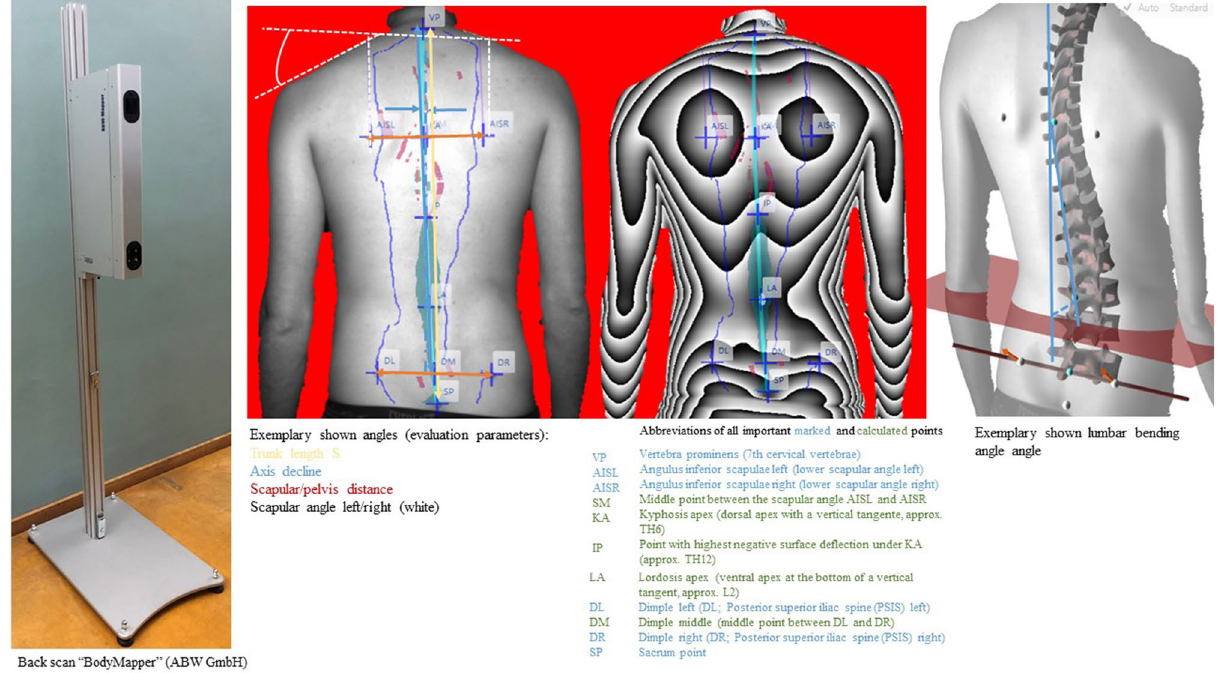
Figure 1. Display of the BodyMapper, drawn exemplary angles, descriptions of marked and calculated points as well as the fictitious calculation of the lumbar bending